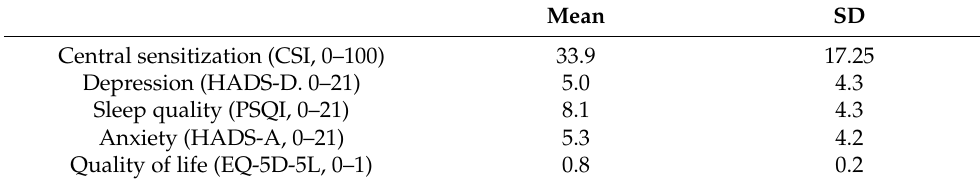
Table 1. Means and standard deviations of study variables.